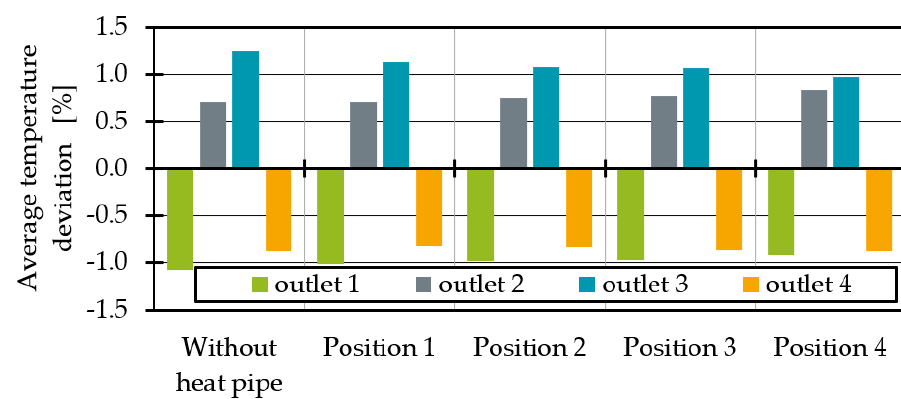
Figure 10. Average temperature deviation for different heat pipe positions.